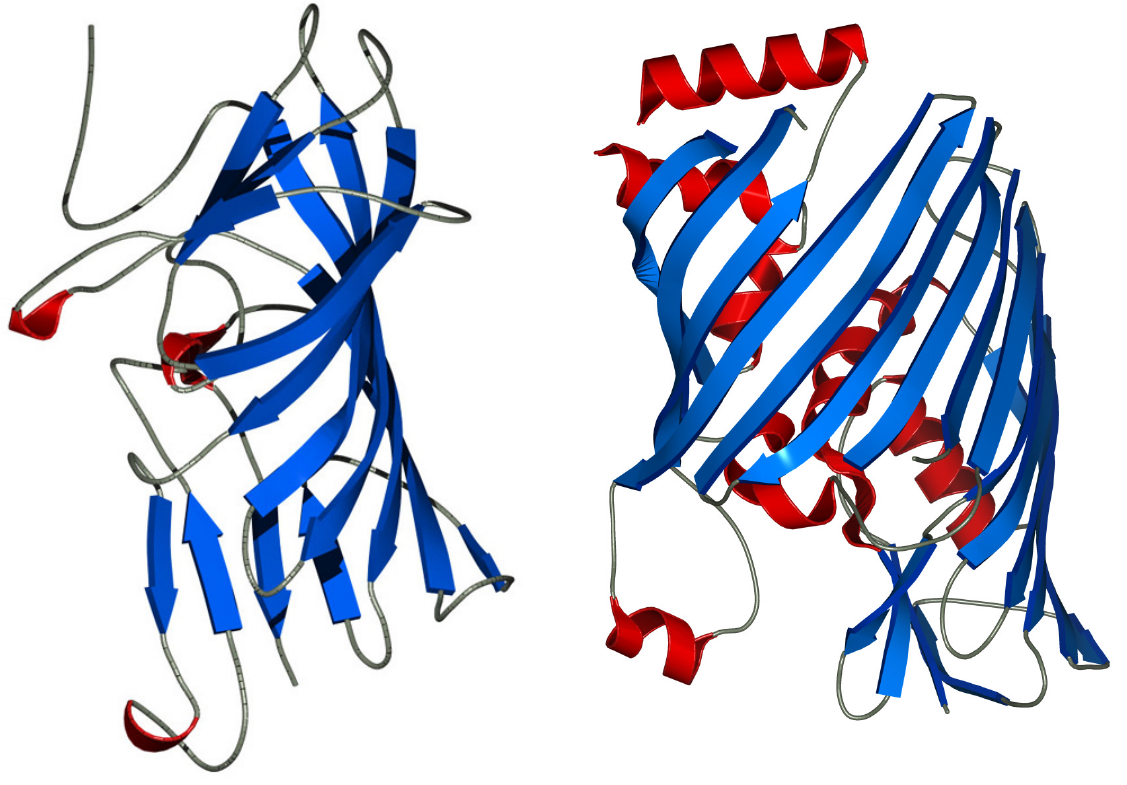
FIGURE 3. Structure of the N-terminal domain and comparison with bacteriochlorophyll a. Ribbon diagrams of the N-terminal domain of